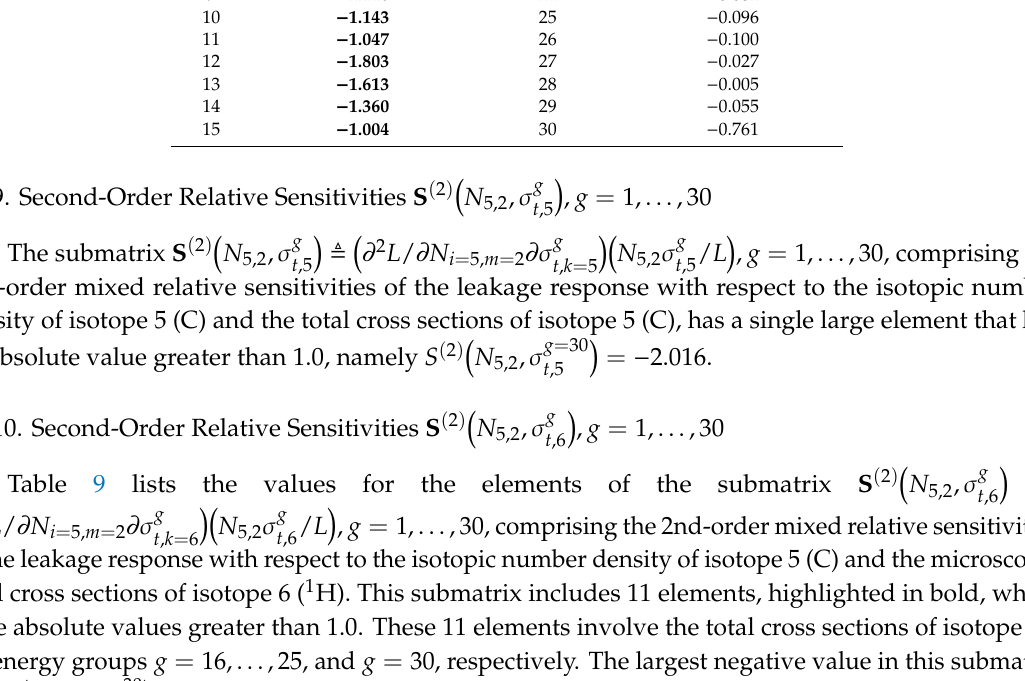
Table 8. Second-Order Relative Sensitivities S ( 2 ) g Relative Sensitivities g Relative Sensitivities